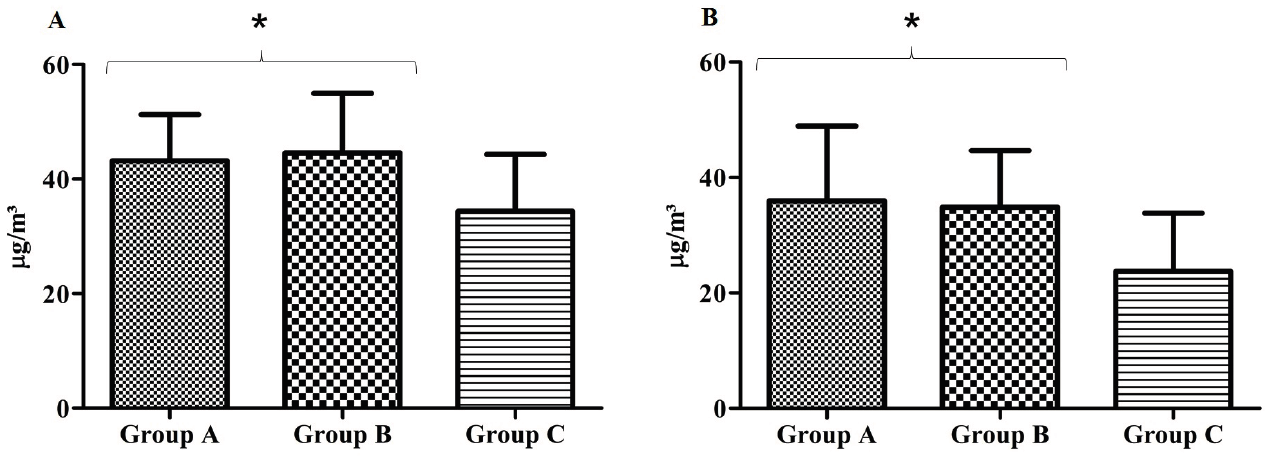
Figure 3. O concentrations in the monitoring areas for summer ( A ) and winter ( B ). 3